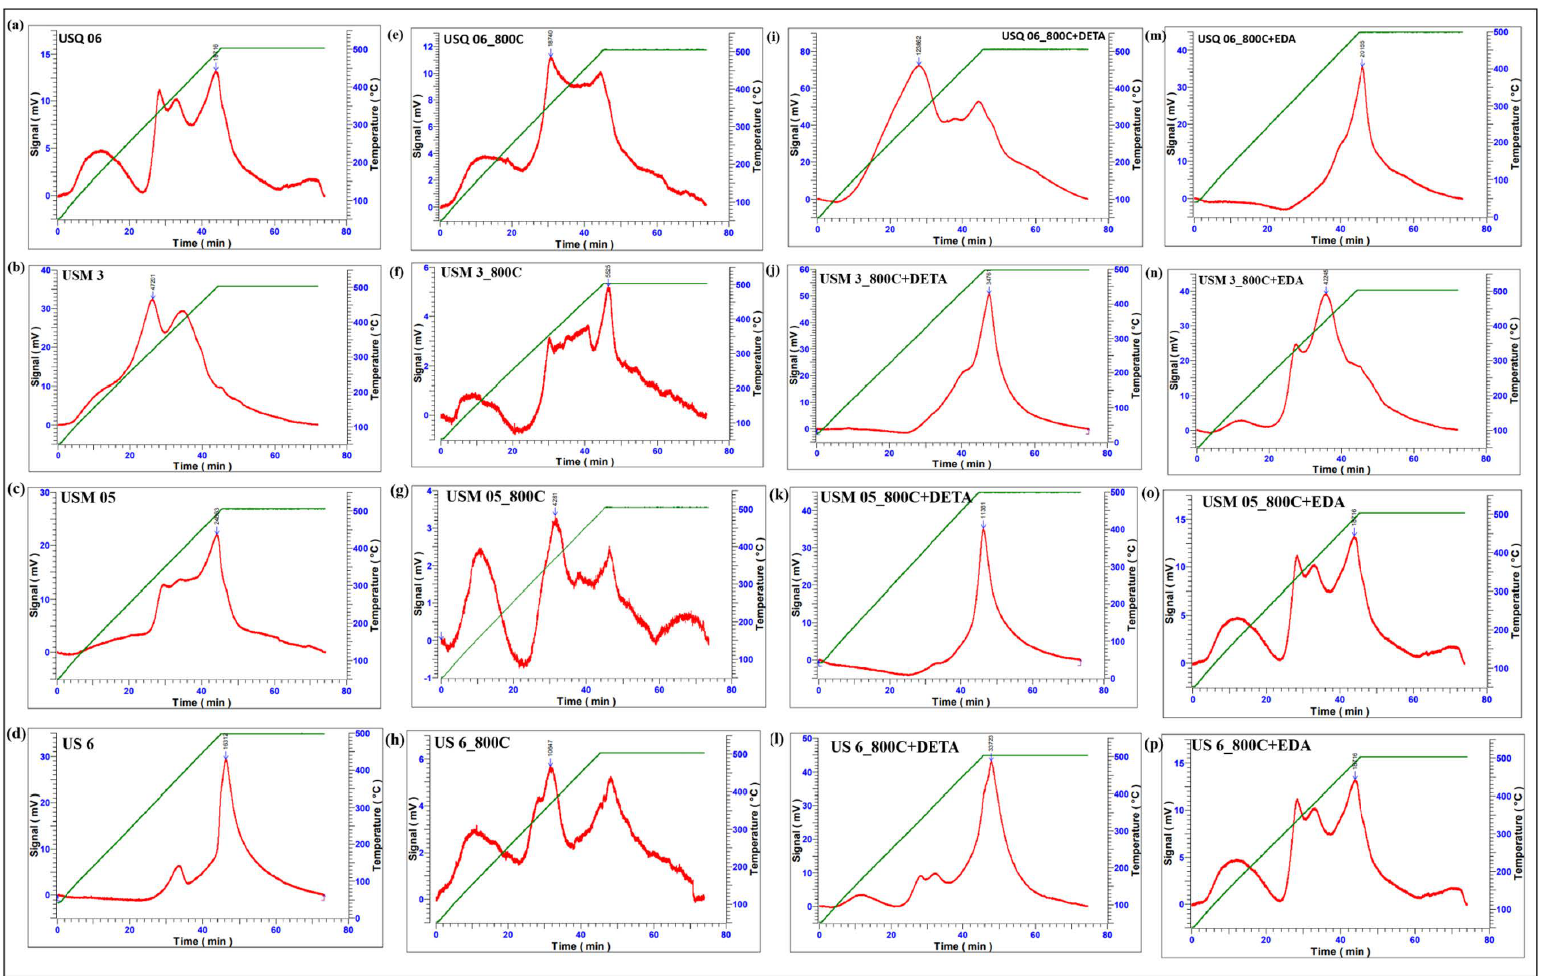
Figure 6. CO 2 desorption sites at maximum temperature observed on Raw shale ( a – d ), spent shale ( e – h ), DETA-modified spent shale ( i – l ), and EDA-modified spent shale ( m – p